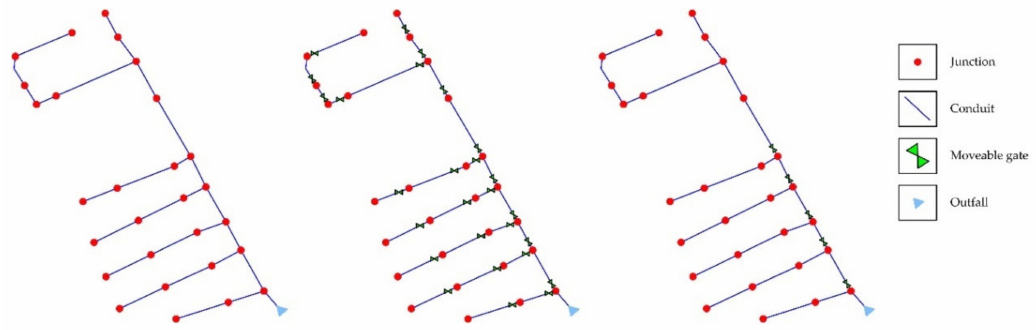
Figure 3. Drainage network schematization. From left to right: Scenario 0, Scenario 1, and Scenario